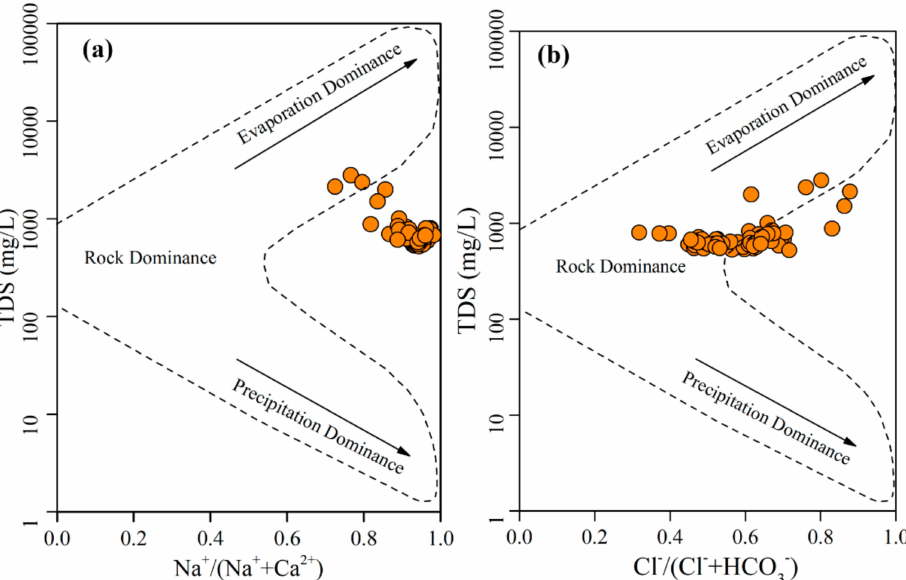
Figure 10. Gibbs diagrams demonstrating the mechanisms governing groundwater chemistry. ( a ) TDS versus Na + / (Na + + Ca 2 + ), ( b ) TDS versus Cl − / (Cl − + HCO 3 −